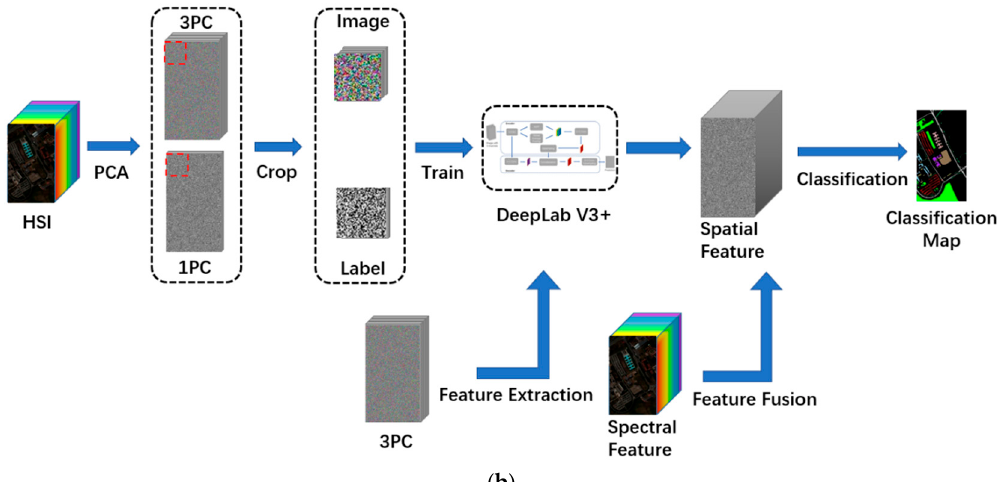
Figure 3. Schematic depictions of the architecture of ( a ) DeepLab v3+ and overall architecture of the ( b ) proposed framework.